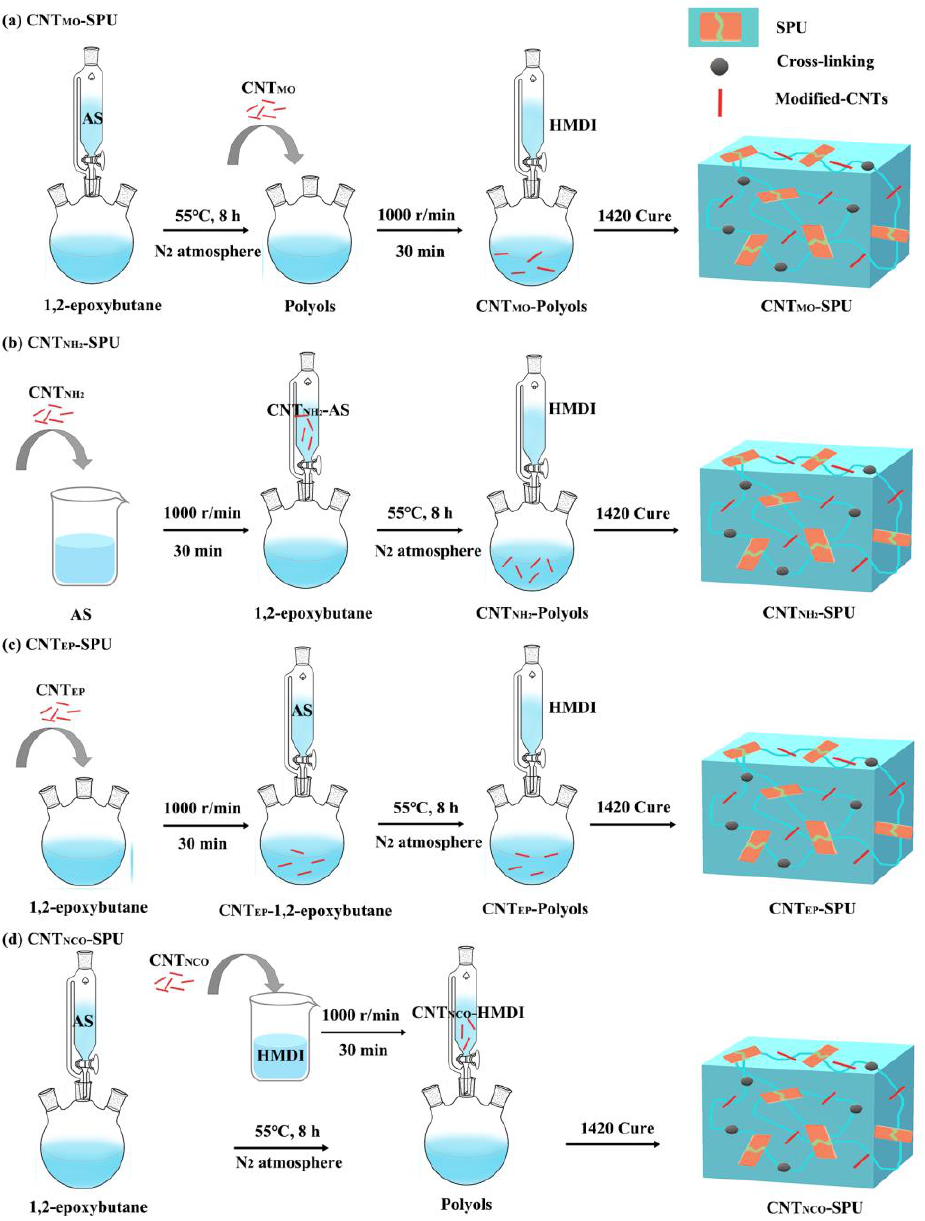
Figure 2. Experimental scheme of modified CNT in SPU. ( a ) preparation of CNT MO -SPU ; ( b ) prepa- ration of CNT NH2 -SPU ; ( c ) preparation of CNT EP -SPU ; ( d ) preparation of CNT NCO -SPU .